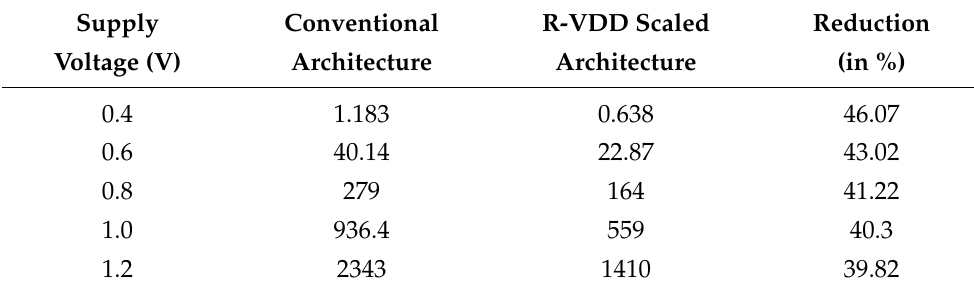
Table 2. Read power (nW) of memory architecture with various supply voltages.